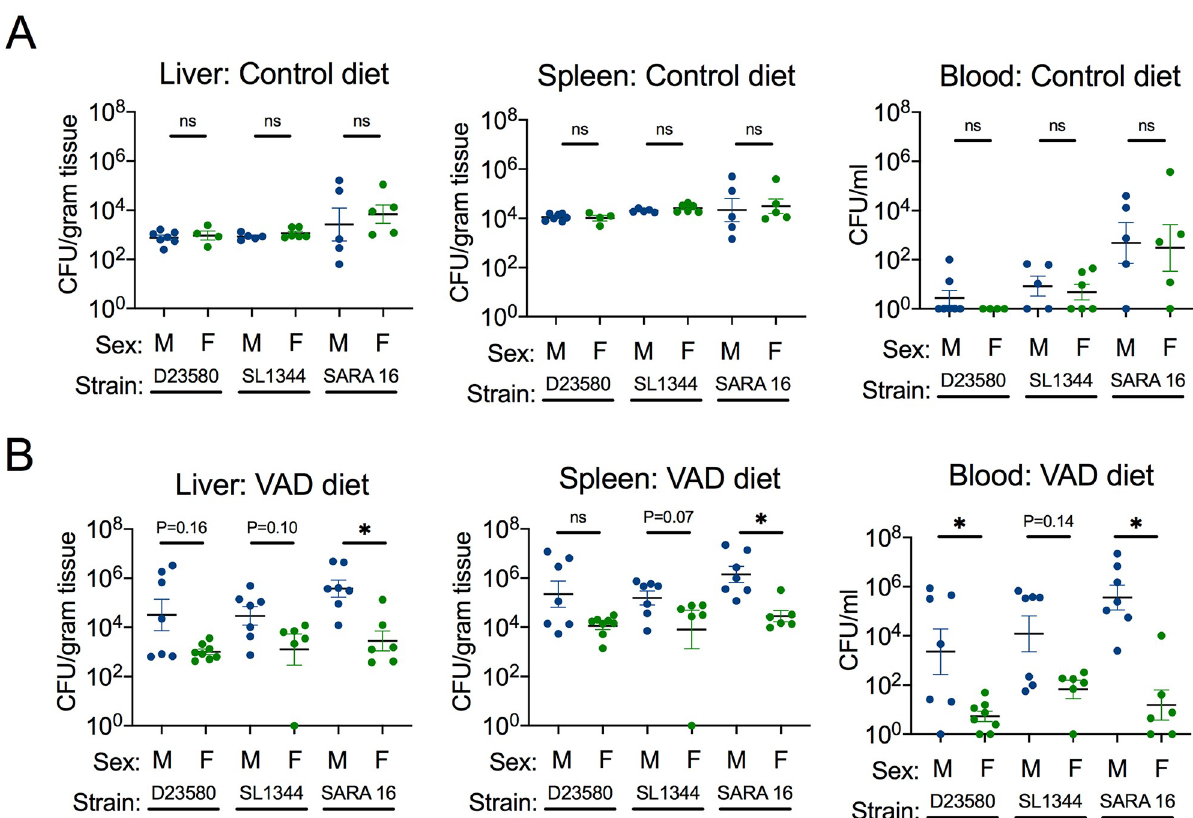
Fig 3. Salmonella strains colonize systemically at higher levels in VAD male mice early in infection. Systemic bacterial burden was characterized by CFU in liver, spleen and blood collected at necropsy 1 day after infection with S . Typhimurium D23580, SL1344 or SARA16 via the i.p. route for male and female mice (n = 4–8) on either control ( A ) or VAD ( B ) diet. Data represent mean ± SEM. Significance between male and female mice was determined with a Mann-Whitney test of log-transformed values ( � , p < 0.05; ns, not